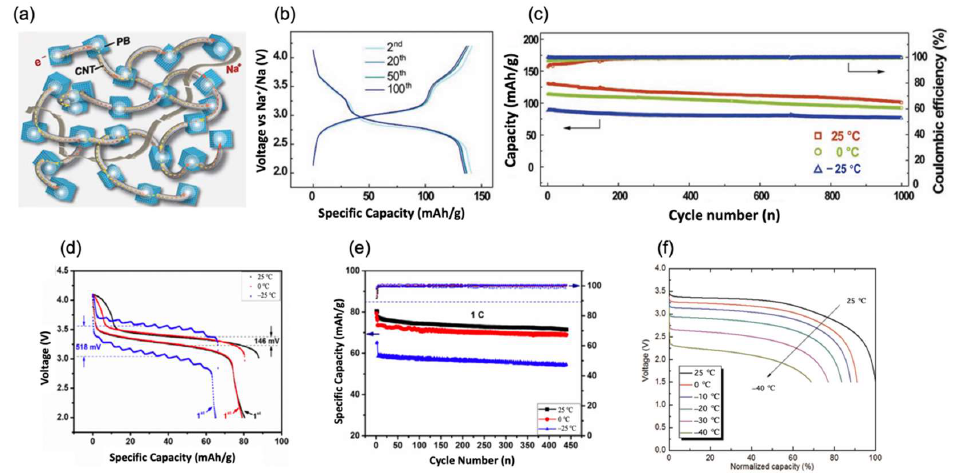
Figure 2. ( a ) The system of PB/CNT with carbon nanotube connecting PB. ( b ) Cycling performance of PB/CNT at a current density of 0.1 C for a long run at − 25 ◦ C. ( c ) PB/CNT has an ultra-long cycle life at a high rate of 2.4 C at 25 ◦ C, 0 ◦ C, and − 25 ◦ C. Reproduced with permission from Ref. [18]. Copyright 2016 WILEY-VCH. ( d ) PBNi-ES temperature comparison for voltage and specific capacities at 0.1 C. ( e ) High rate of 1 C and long cycle performance of PBNi-ES. Reproduced with permission from Ref. [19]. Copyright 2018 Elsevier. ( f ) Cell performance at a range of temperatures from an ambient temperature to an extremely low temperature of − 40 ◦ C at a 1 C rate. Reproduced with permission from Ref. [21]. Copyright 2018